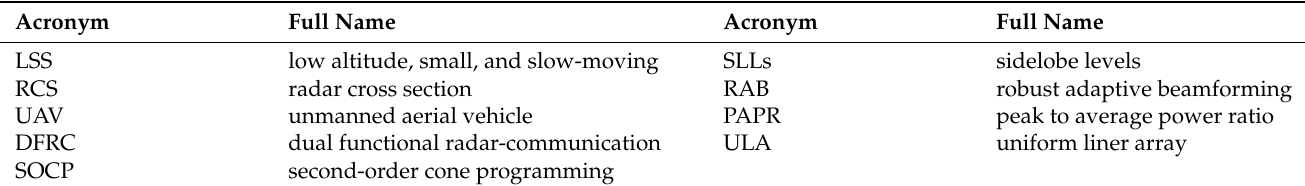
Table 1. List of